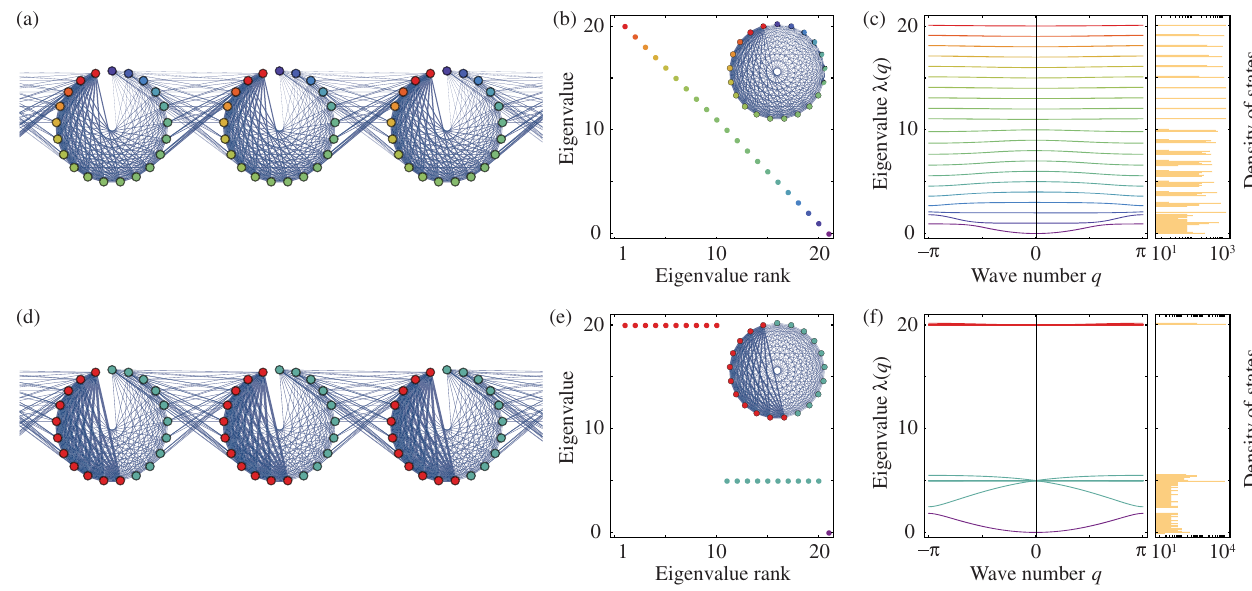
Designed spectra on a discrete network are preserved when extended periodically in one dimension. (a) We extend a finite network to an infinite one by rewiring a subset of the edges to cross between adjacent copies of the original network. Here, we take the network with the spectrum in (b) and rewire the edge between vertices j and k if j k − j j > n= 2 . This rewires roughly one quarter of the 21 − j . (c) Most of the eigenvalue bands do not change edges. (b) One unit cell in (a) would have a discrete spectrum with λ j ¼ significantly with q , so the density of states consists of 21 sharp peaks with low- or zero-density regions between. (d) The same construction as in (a) can be repeated for any spectrum; this is the result for a gapped network. (e) One unit cell in (d) would have a gapped spectrum, with 10 eigenvalues equal to 20 and 10 equal to 5, in addition to the always-present zero eigenvalue. (f) Again, most of the eigenvalue bands are roughly constant, even though the eigenvectors do depend strongly on q . The gap in the middle of the spectrum is nearly perfectly preserved; a small gap remains between the bottom two bands. Note the log scale on both density of states